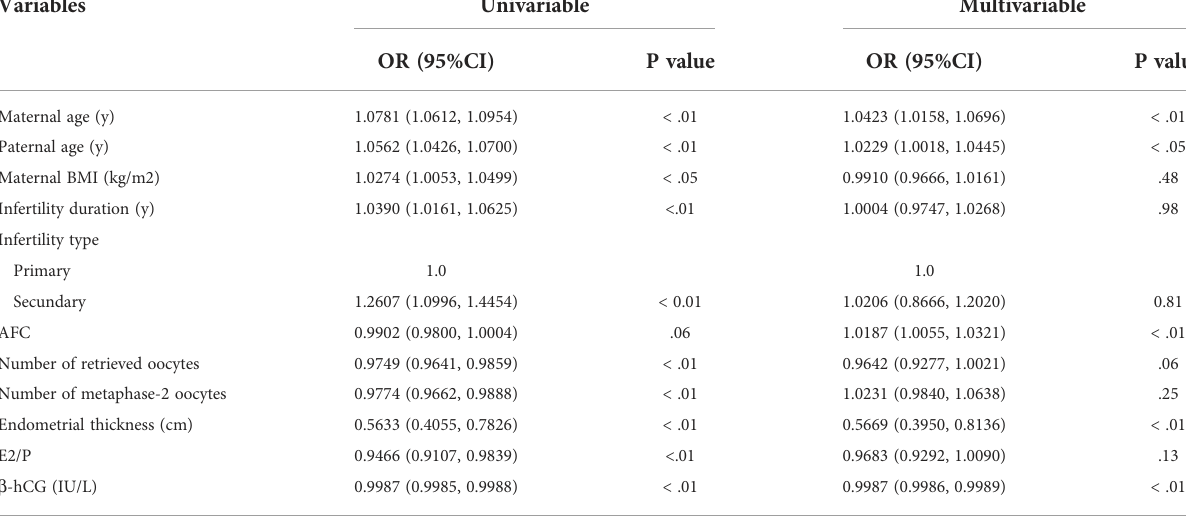
TABLE 2 The risk factors associated with the incident early pregnancy loss in fresh IVF/ICSI cycles.